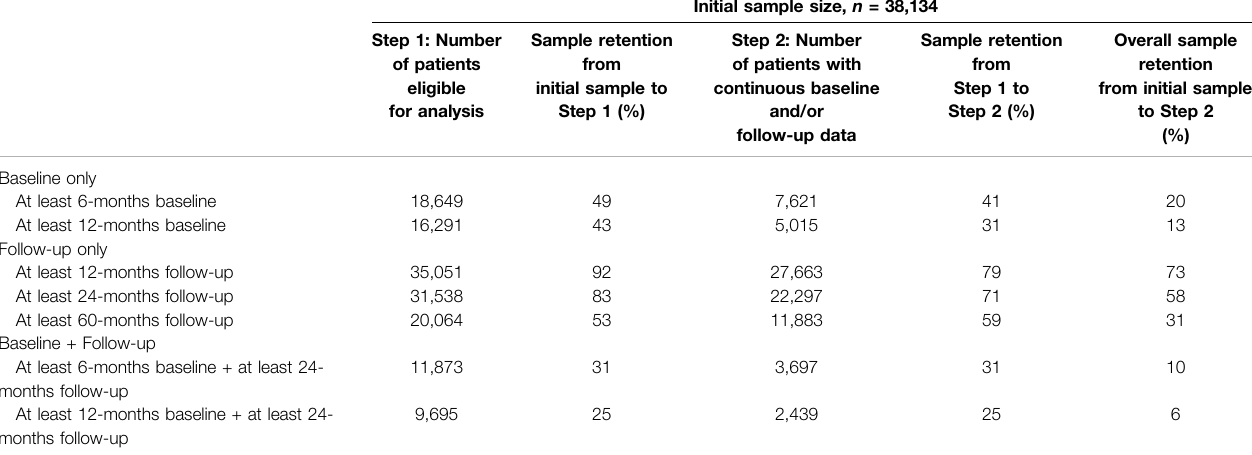
TABLE 4 | Sample attrition and data continuity among patients with type 2 diabetes mellitus in the Integrated Medical Database of National Taiwan University